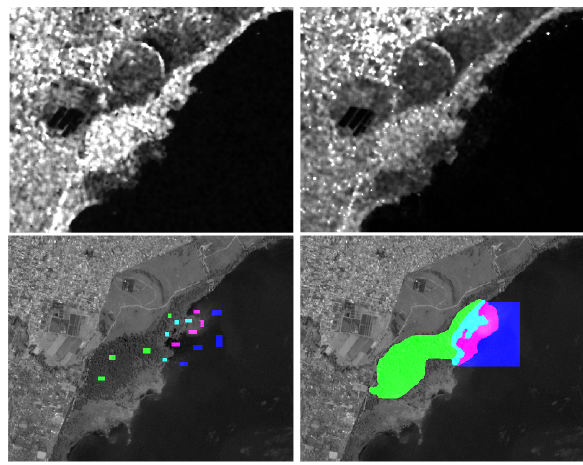
Figure 7: Sentinel-1 VV and VH images (13/08/2019) on the studied area (filtered by 7 × 7 Lee filter) together with the train and validation sets (shown on the corresponding Sentinel-2 im- age). Color codes: Green: healthy forest; Cyan: damaged forest; Magenta: submerged trees; Blue: